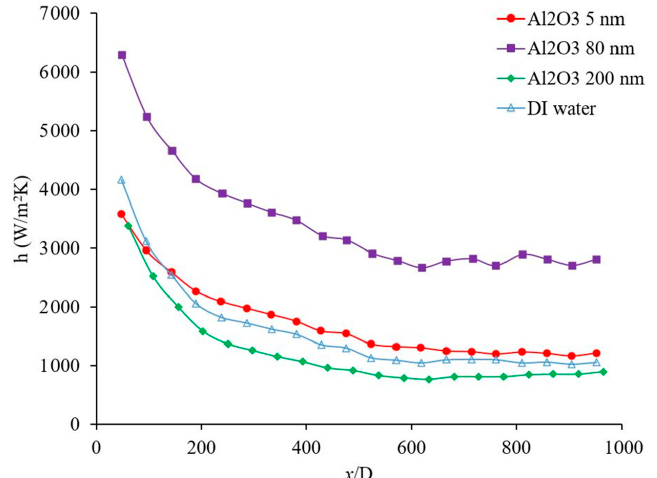
Figure 17. Variation of forced convection heat transfer coefficient as a function of distance for Al 2 0 3 -water nanofluids. Nanofluid concentration was 1 wt % , and the range of Reynolds number inside the microchannel was 150–200. Comparison between effects of Al 2 O 3 nanoparticles of sizes varying from 5 nm to 200 nm.